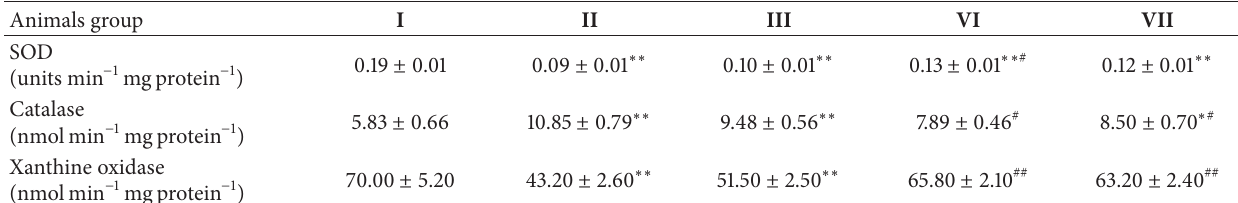
Table 2: Influence of compounds 3 (group VI ) and 4 (group VII ) (1mg/kg, IP, 30 min before WIRS) on the activity of antioxidant enzymes in homogenates of rats gastric mucosa ( 𝑛 = 6 , M ±